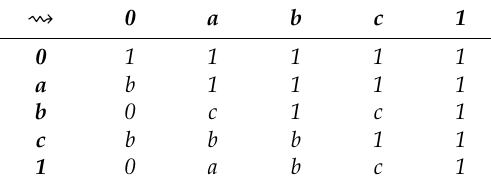
Table 3. The operation (cid:32) on X